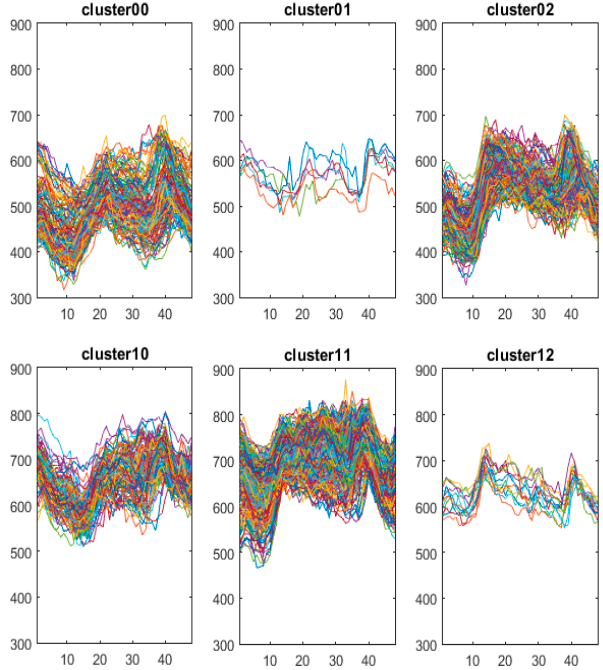
Figure 8. Weighted Pearson results.